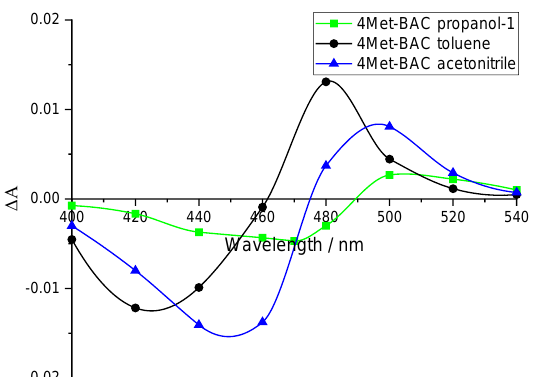
Figure 8. Differential transient absorption spectra of 4Met-BAC (7 × 10 − 7 M) in air-equilibrated solvents (green—propanol-1, black—toluene, blue—acetonitrile) 100 ms after flash.